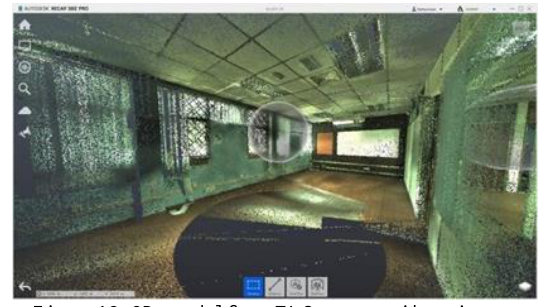
Figure 13: 3D model from TLS comes with an image.